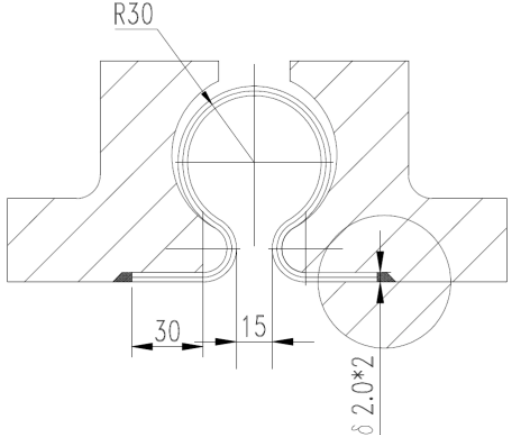
Figure 1. Illustration of a typical toroidal bellows (mm).